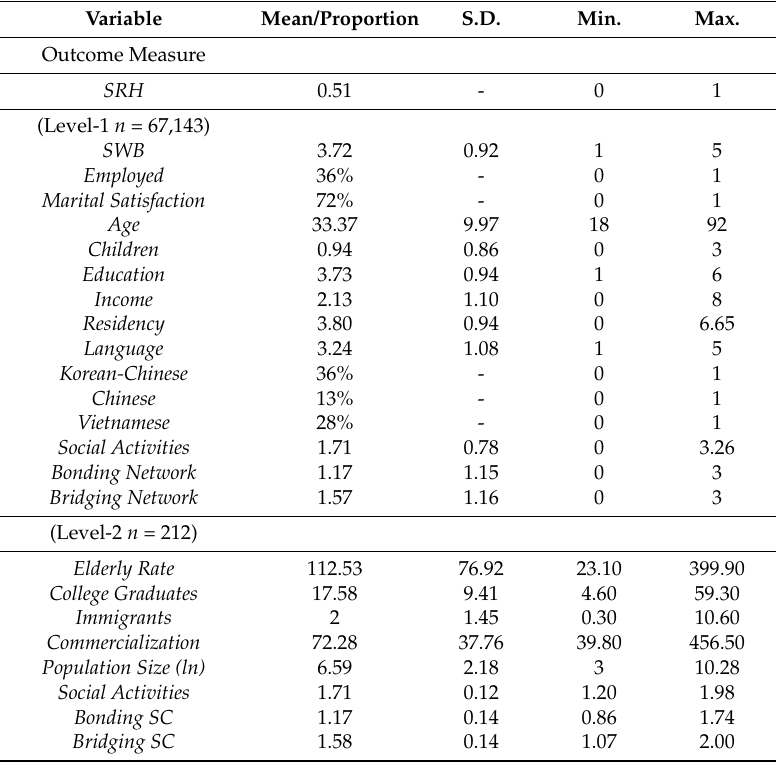
Table 2. Descriptive